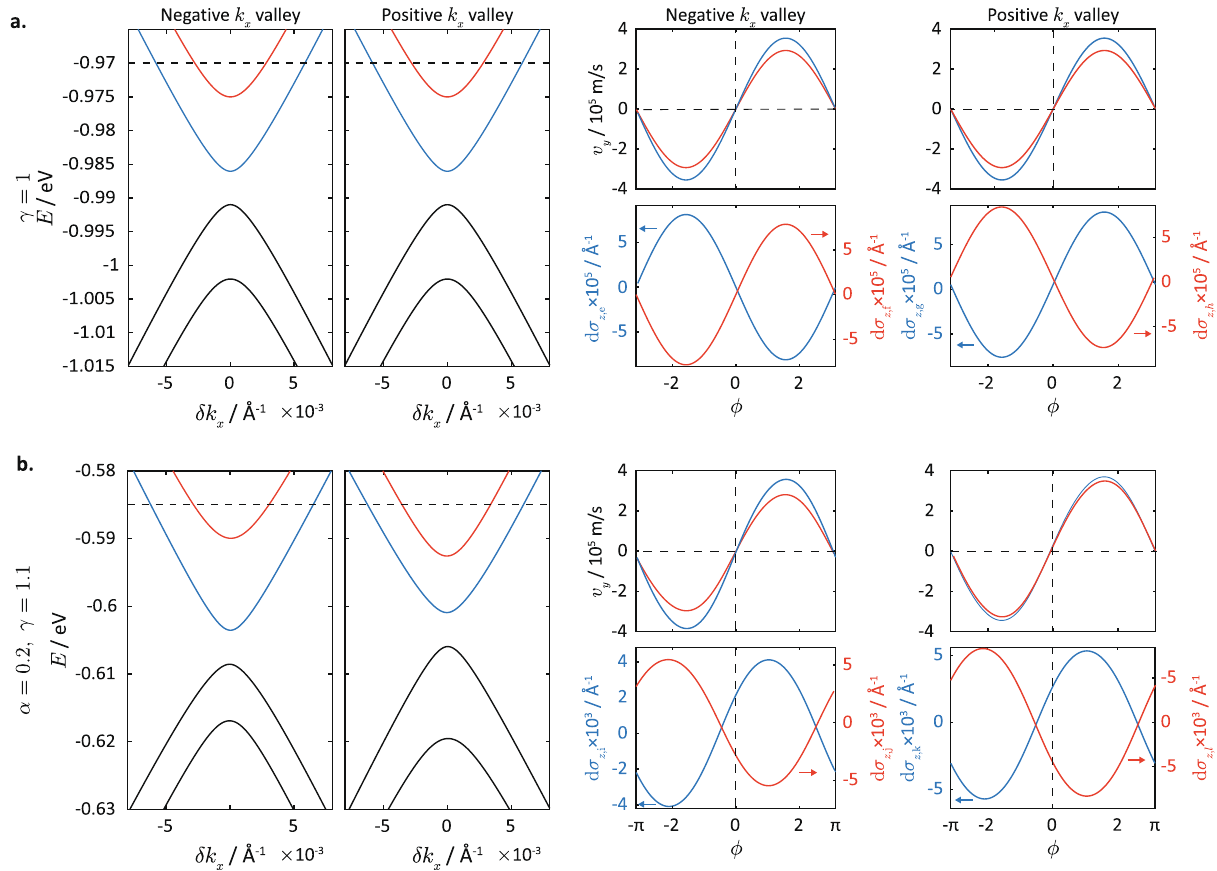
Figure 5. Comparison of the bandstructure and current-induced spin accumulation between strained and unstrained silicene. ( a )The dispersion relations at δ k y = 0 , expectation values of the group velocity v y and out-of-plane spin accumulation offsets d σ z , a ≡ � σ z � − σ 0 a , a = ( e, f, . . . , l ) at the positive k x (left) and negative k x (right) valleys for unstrained silicene at electron energy E = − 0.97 eV. ( b ) The corresponding plot to (a) strained silicene with α = 2, γ = 1.1 at E = − 0.585 eV , with an applied M x = 5 meV and E z = 8 meV. Here, = − σ 0 = 0.27132 Å − 1 , σ 0 = 0.125 Å − 1 , = − 0.15708 Å − 1 , σ 0 = − σ 0 = − 0.110 Å − 1 , σ 0 = − 0.183 Å − 1 , σ 0 σ 0 g e i j f h k − 1 and σ 0 i = − 0.212 Å . The electron energies of E = − 0.97 eV and E = − 0.585 eV are indicated by dotted lines H (cid:30) and (cid:31) σ z (cid:30) plots correspond to in the dispersion relation plots in ( a ) and ( b ), respectively. The colours of the (cid:31) ∂ k y the bands in the dispersion relations plotted with the respective